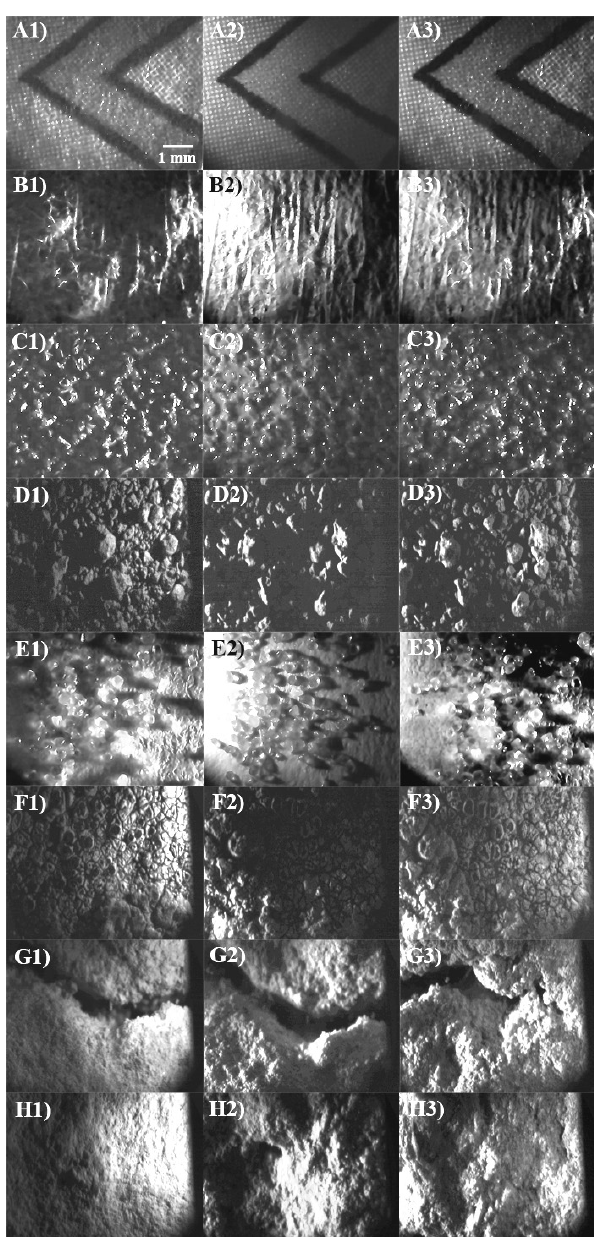
Figure 3. Results of the laboratory tests with the first camera ver- sion to see the differences between two illumination types with of grazing and direct orientations. The first column of the matrix shows the target with the grazing illumination, the second shows the same target with the direct illumination and the third column shows the same target using both illumination types. The objects of the tests (from top to bottom) are: reference colours (A1-A3), rough surface paper (B1-B3), sandpaper (C1-C3), Mars analogue sand (D1- D3), Sahara sand (E1-E3), bacterial colonies covered rock surface (F1-F3), cracks of rock (G1-G3) and sandstone surface